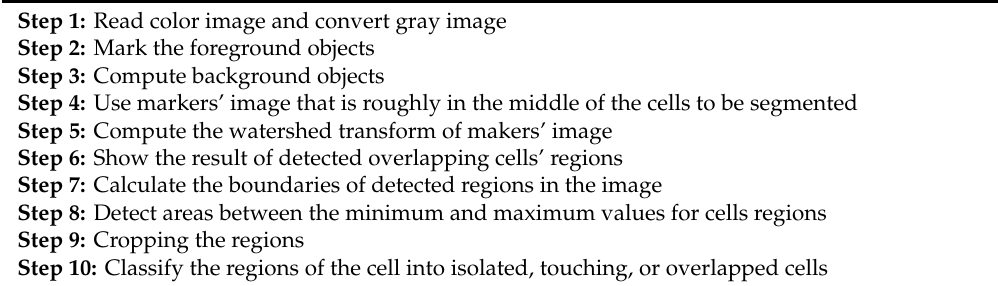
Table 3. Processing steps of proposed overlapping cells’ segmentation method.